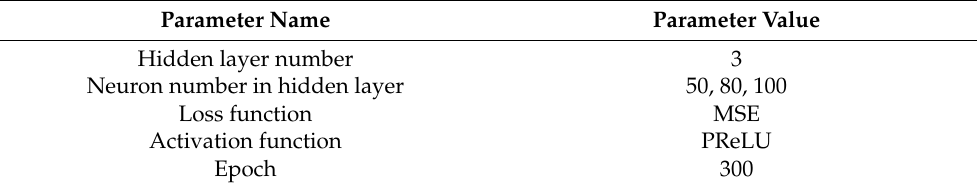
Table A2. LSTM configuration and parameters used to train LSTM